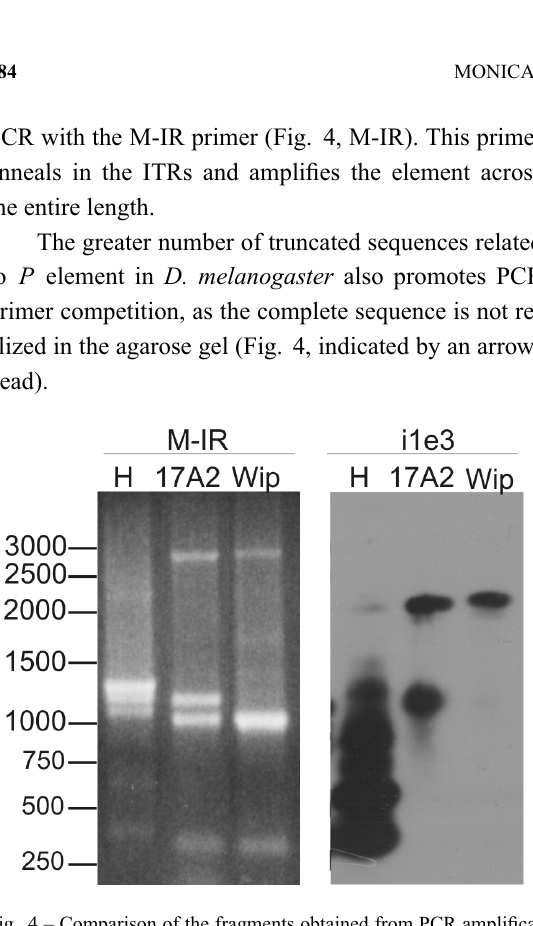
Fig. 4 – Comparison of the fragments obtained from PCR amplifica- tion of adult genomic DNA and the fragments obtained from RT-PCR of embryos of D. melanogaster (H) and D. willistoni (17A2 and Wip). (M-IR) Agarose gel electrophoresis with genomic PCR products with M-IR primer. (i1e3) Southern blot, using the canonical P element as probe, of the RT-PCR amplification with meli1+ and mele3- primers. The arrowhead indicate the complete P element sequence and the nar- row arrow the repressor of 66-kDa fragment. A 1-kb DNA ladder is shown on the left.